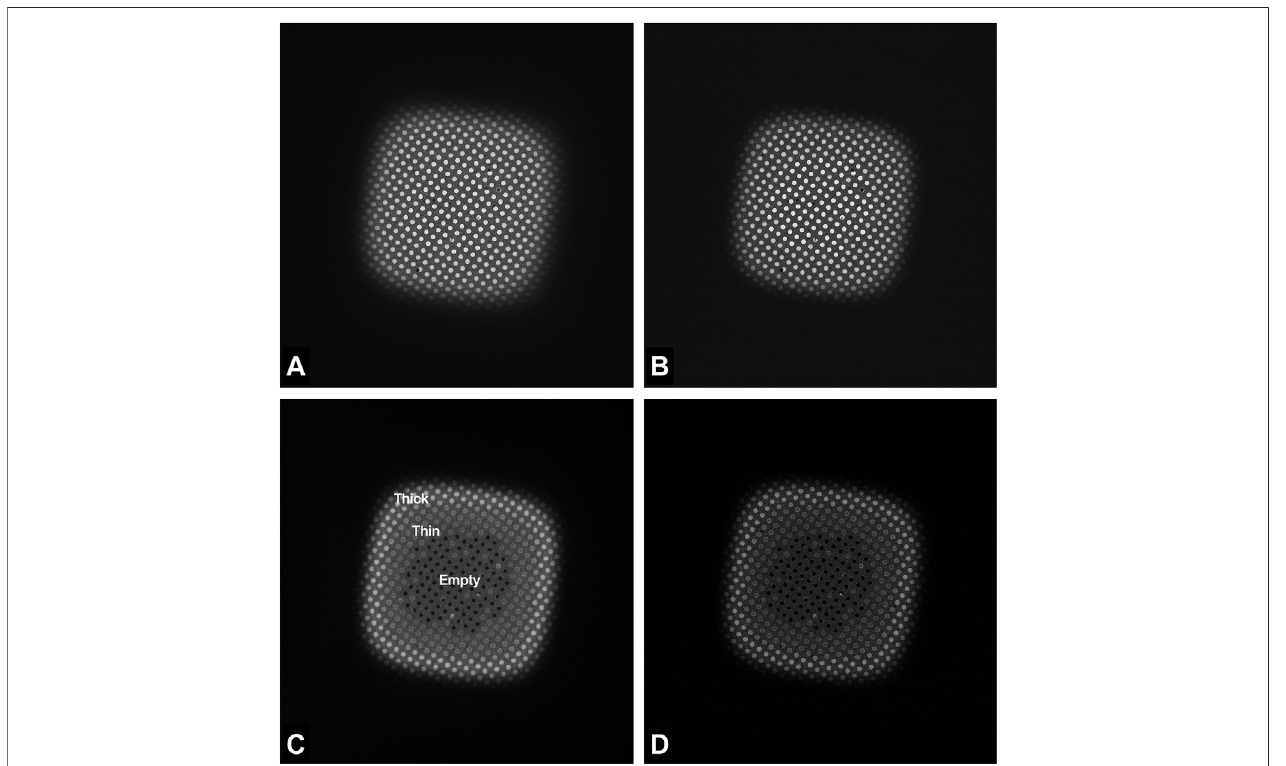
FIGURE3 | Images ofaQuantifoil UltrAuFoil 1.2/1.3 grid square, acquired on aThermoScienti fi cTitan Krios G1with Gatan Bioquantum K2 detector using EFTEM LM mode ×740 magni fi cation ( fi eld of view ×67 69 μ m), 1-s exposure, total dose 0.003 e/Å 2 . Image contrast/brightness has not been changed manually. (A) Un fi ltered image, (B) Zero loss fi ltered linear mode image, (C) plasmon counting mode image, and (D) plasmon counting mode image with 40 μ m SA aperture